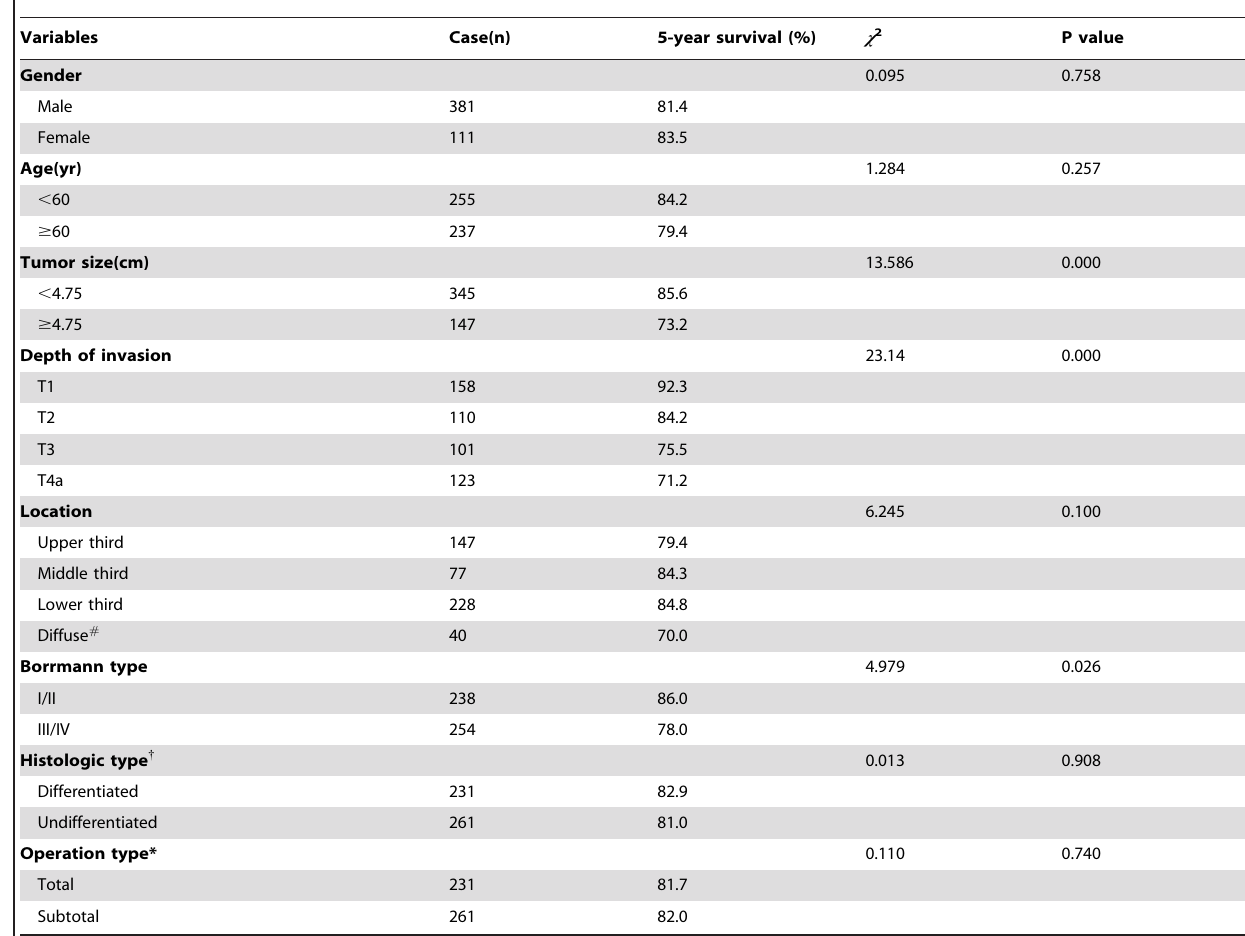
Table 1. Univariate analysis of patients by Kaplan-Meier method.